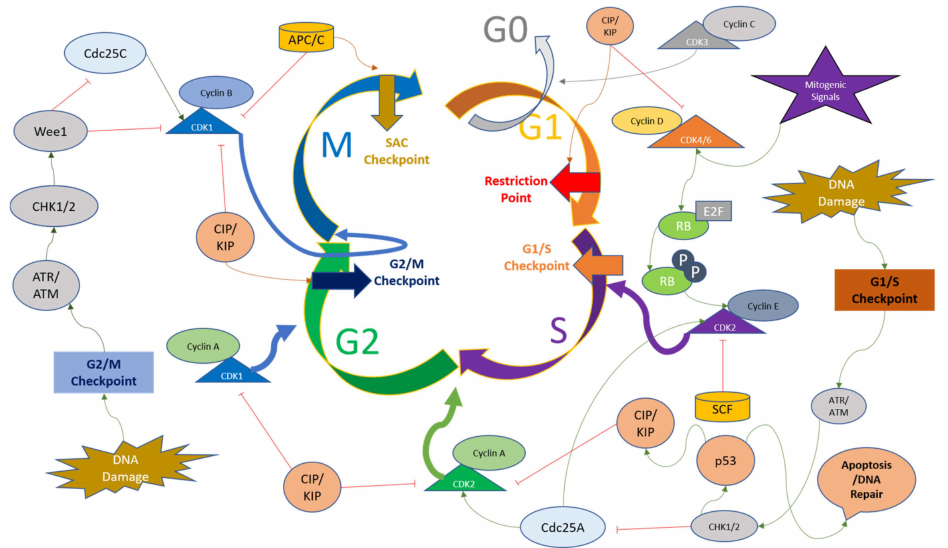
Figure 2. Overview of cell cycle regulation with respect to CDKs and their major regulators. The upstream factors of Cyclins and CDKs can either activate or downregulate their respective functions and cause the cell cycle to halt at various time points including the G1 restriction point, G1/S checkpoint, G2/M checkpoint, and Spindle Assembly Checkpoint (SAC). The description of these factors and their action on Cyclins and CDKs are detailed in the main